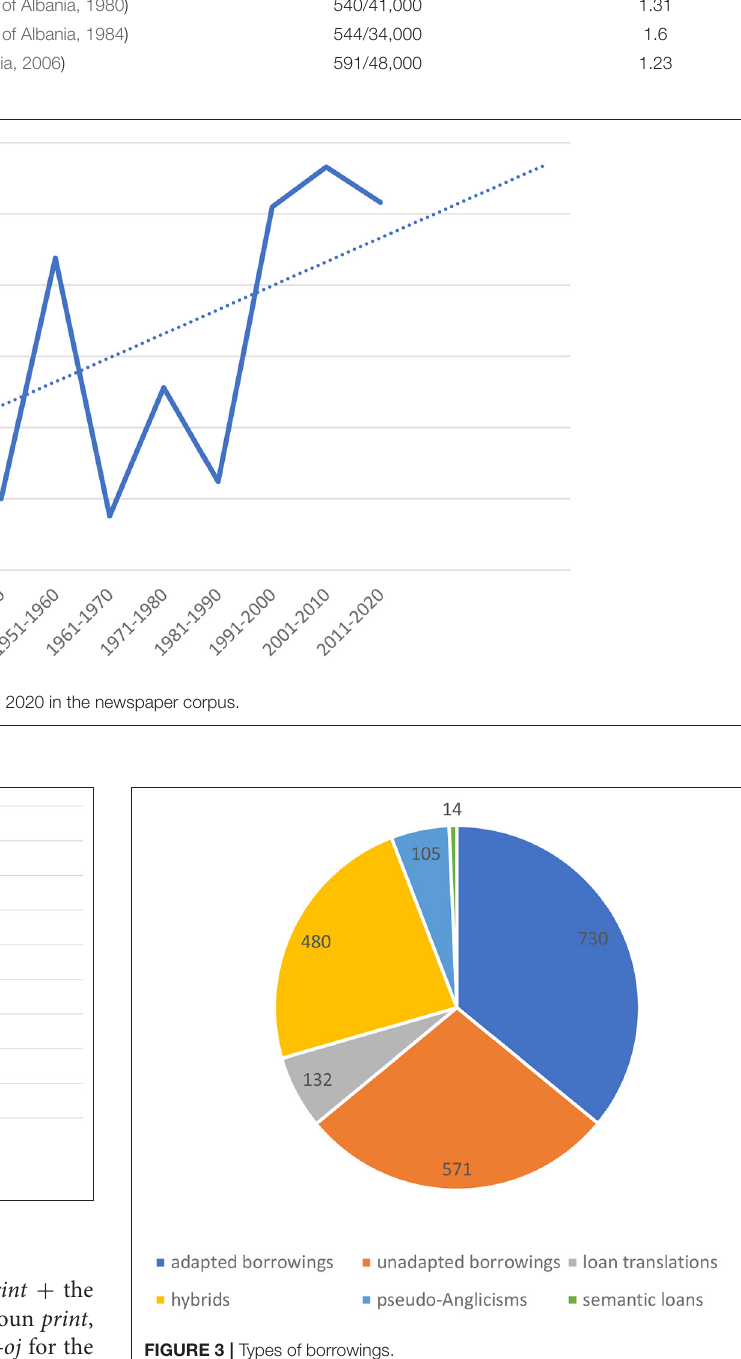
Figure 3 includes 141 “short-life Anglicisms” and 77 “revived